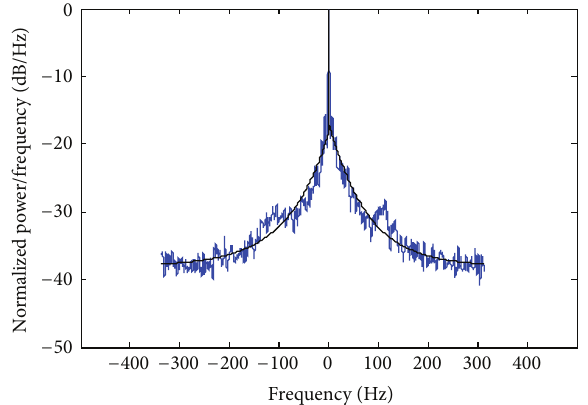
Figure 9: Example A: estimated PSD and corresponding exponen- tial fitting ( 𝑎 = 19.72 , 𝑏 = 1.22 ⋅ 10 −2 , 𝑐 = 38.05 , 𝑑 = 21.42 , 𝑒 = 1.29 ⋅ 10 −2 , 𝑔 = 38.08 , 󳵻𝑓 = 651.11 , and 𝛾 = 0.04 ).